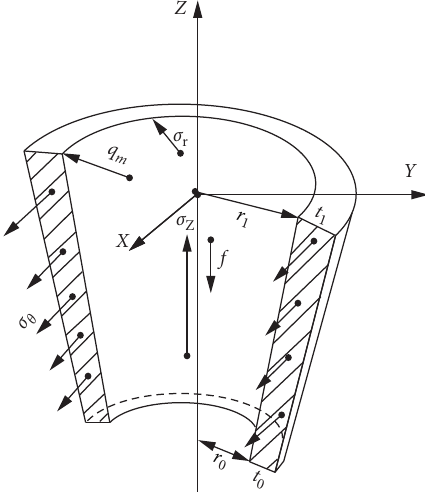
Figure 4: Distribution of forces applied to the expandable